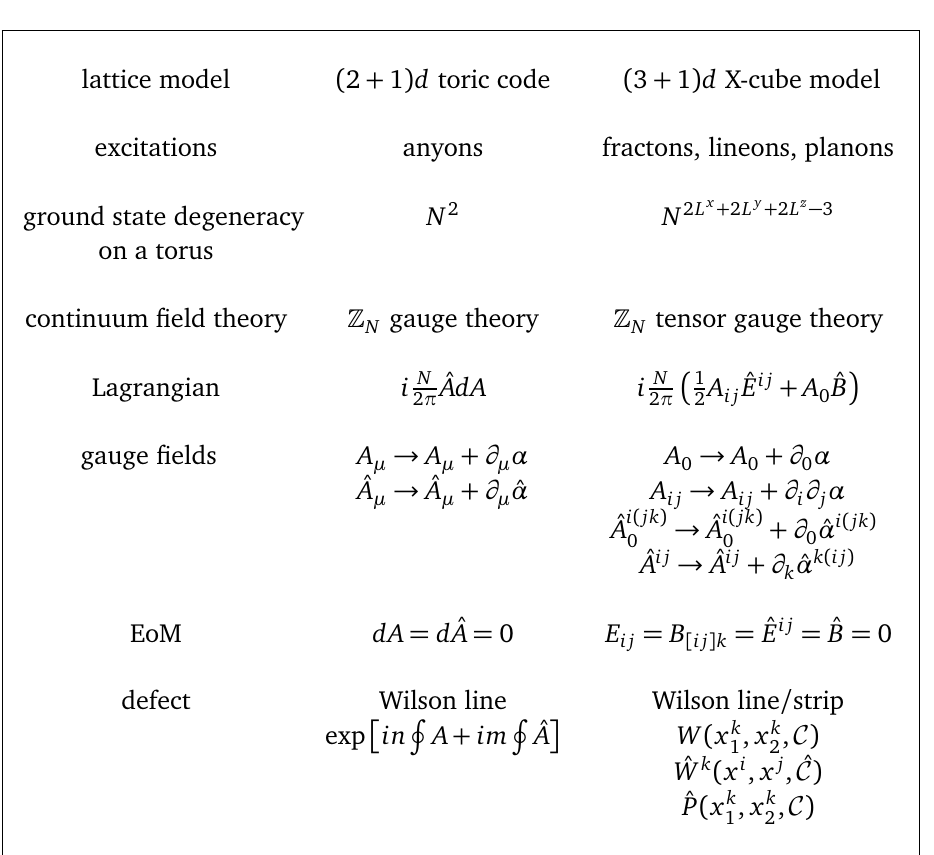
Table 4: Analogy between the toric code and the X-cube model. Here C is a spacetime curve in ( t , x i , x j ) and ˆ C is a spacetime curve in ( t , x k )